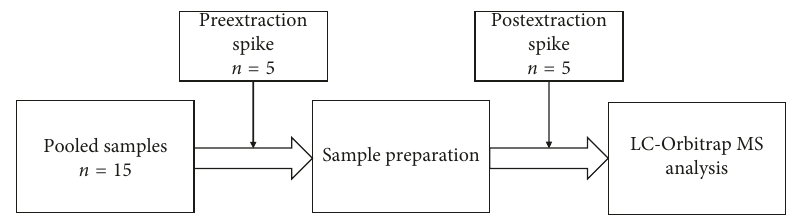
Figure 1: Experimental setup for assessment of recovery, matrix effect, and entire sample preparation